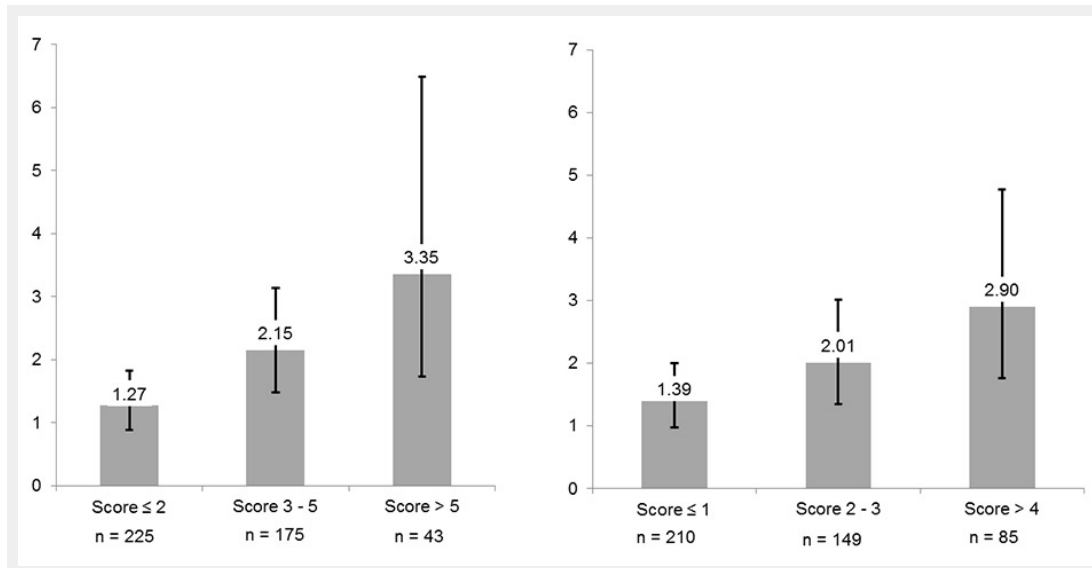
Figure 4 Relationship between nicotine dependence and pre-diabetes Data are with (left side) and without (right side) including information on cumulative smoking exposure into the score. Never smokers represent the reference group. Boxes indicate odds ratios, whiskers are 95% confidence intervals adjusted for age, sex, Body Mass Index, hypertension, alcohol consumption, education, low density lipoprotein and high density lipoprotein cholesterol, physical activity, fruit/vegetable consumption and body